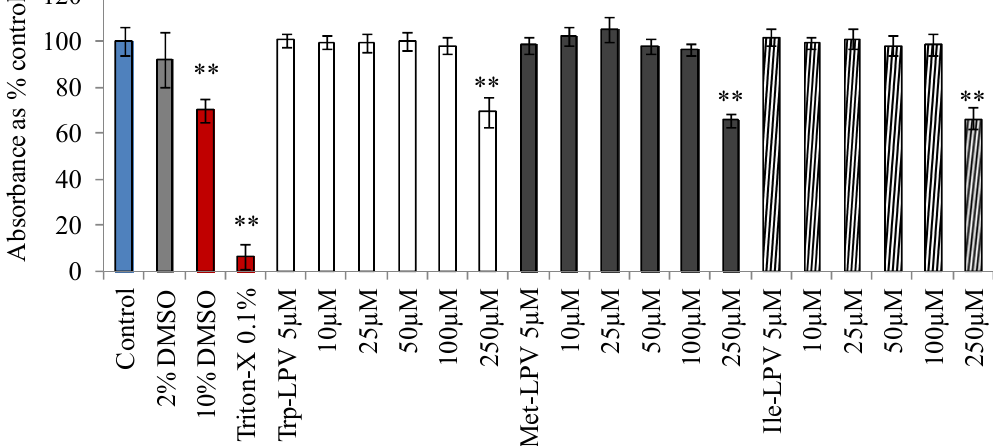
Figure 1. Cytotoxicity result obtained in MDCKII-WT cells following 4 h incubation with prodrugs, Trp-LPV (empty bars), Met-LPV (filled bars) and Ile-LPV (striped bar).